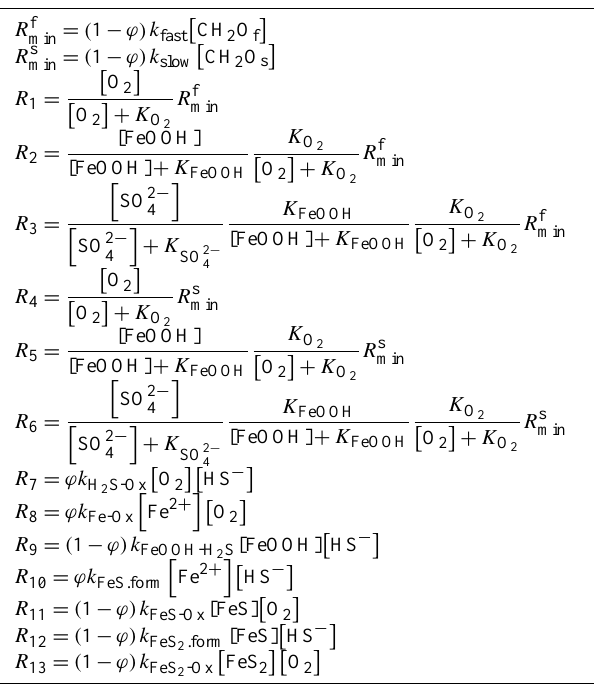
Table 2. Kinetic rate expressions for the reactions included in the reaction